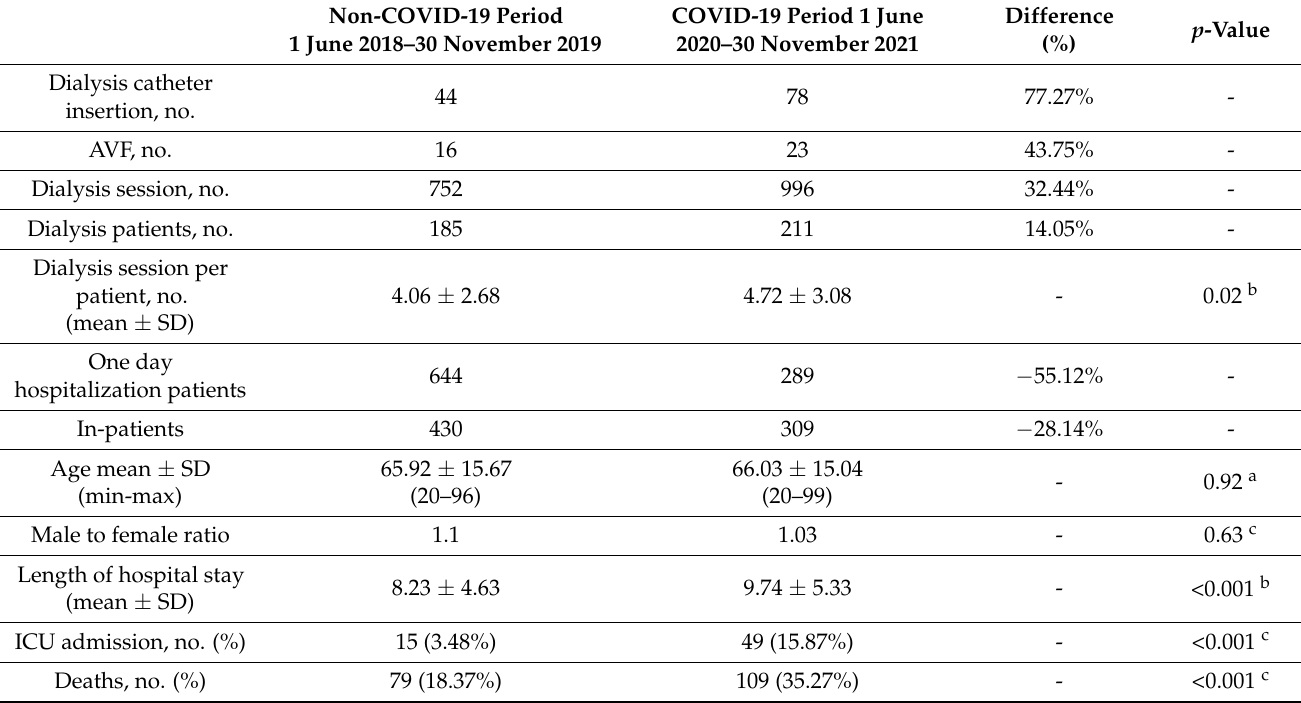
Table 1. Characteristics of the pre-pandemic and the pandemic periods. Non-COVID-19 Period